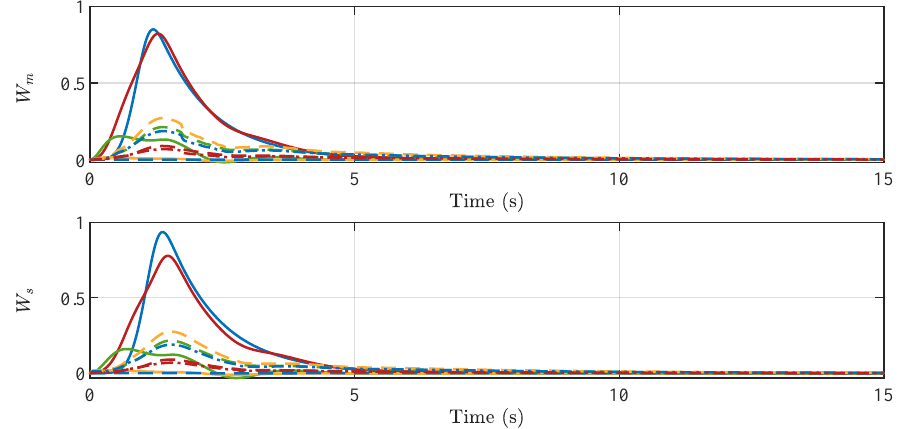
Figure 8. Adaptive parameters in the RBF neural networks ˆ W m and ˆ W s .